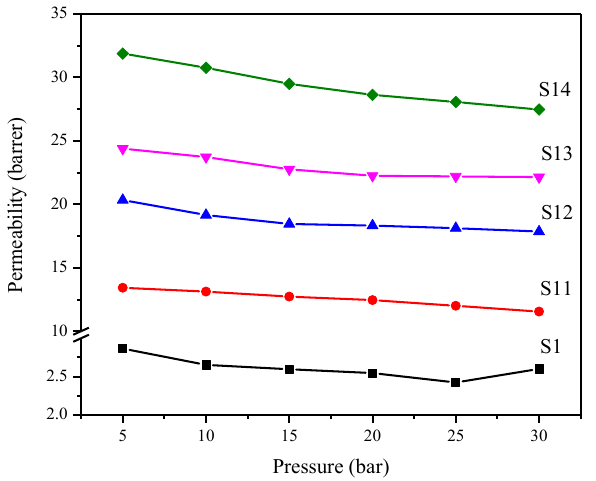
Figure 9. Effect of feed pressure on CO 2 permeability of PES/modified silica MMMs.